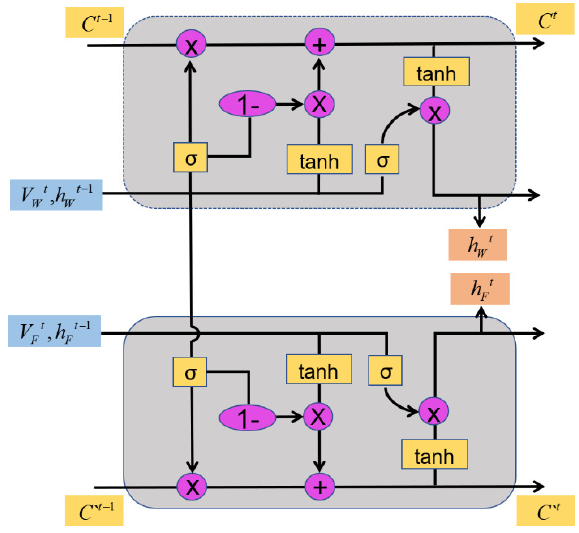
Figure 6. The neuron unit structure of